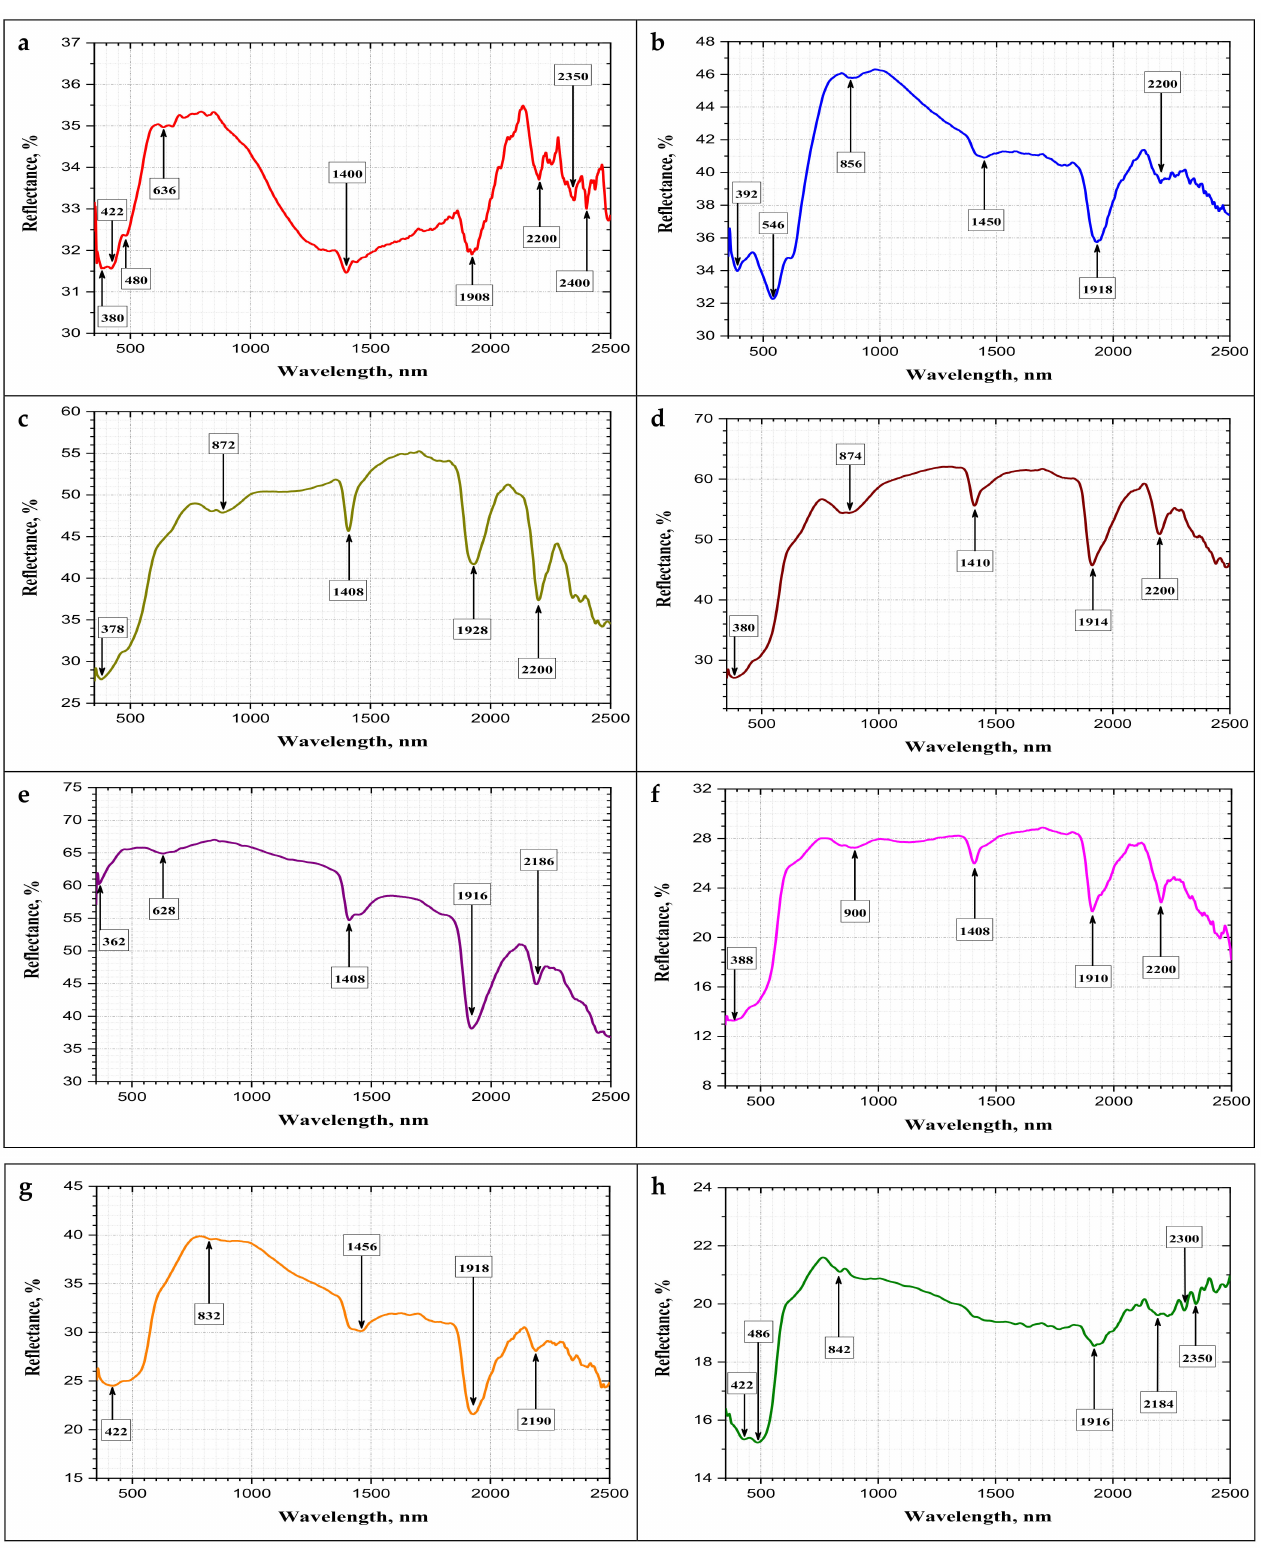
Figure 9. Spectral reflectance patterns in VIS-NIR and SWIR regions (350–2500 nm) of different granitic rocks: ( a ) gandonna; ( b ) pink granite; ( c ) buff granite I; ( d ) buff granite II; ( e ) fantazia; ( f ) red granite; ( g ) rosa granite; ( h ) qusseir